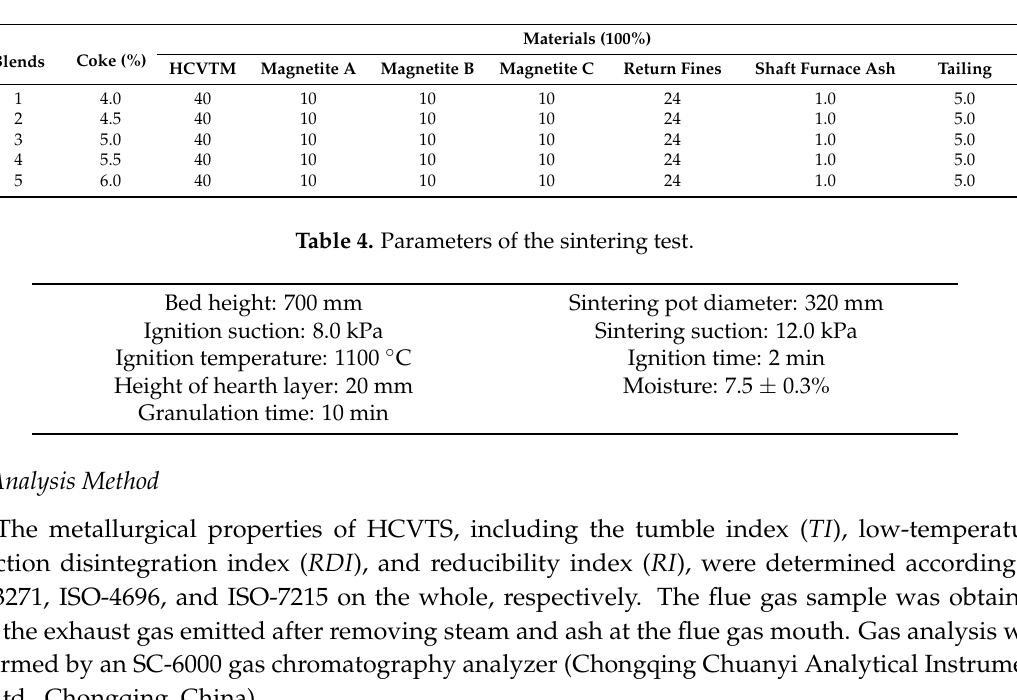
Table 3. Blend composition and sinter chemistry target of the sinter test (mass fraction, %).